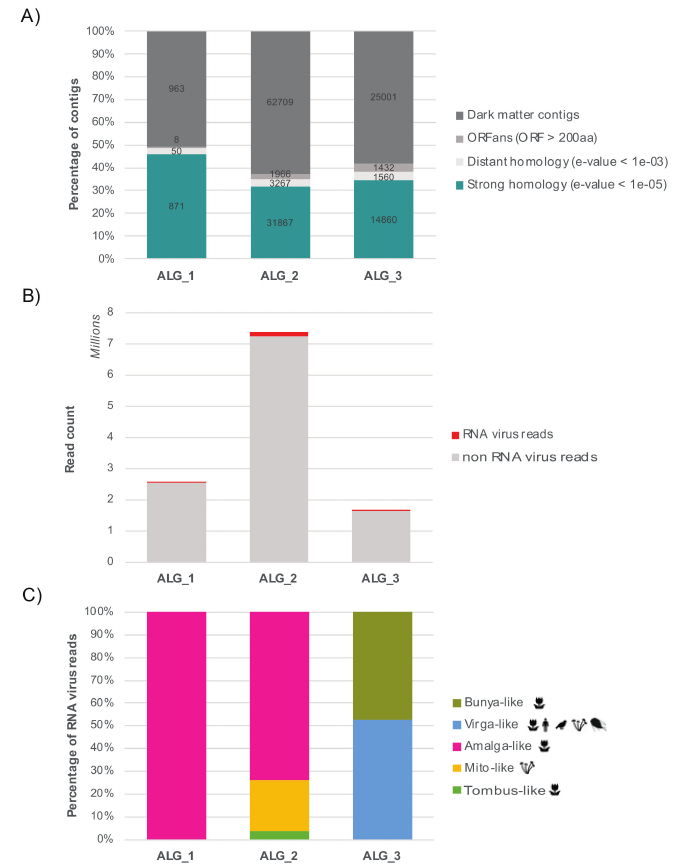
Figure 2. Abundance of unknown and RNA virus-like contigs detected in the algal libraries. ( A ) Percentage of nonassigned contigs. For clarity, numbers are normalized as the percentage of total contigs (actual contig numbers are indicated in bold). Blue: number of contigs showing strong sequence similarity to the nr database (e-value < 10 − 05 ); light grey: contigs showing weak sequence similarity to the nr database (e-values 10 − 05 to 10 − 03 ); middle-dark grey: contigs with no sequence similarity detected by BLASTx / BLASTp but predicted to encode one or more ORFs longer than 200 amino acids (600 nt); dark grey: genomic ‘dark matter’ - contigs without any signal detected or any long ORFs encoded. ( B ) Total number of RNA virus reads per total number of non-rRNA reads in each library. ( C ) Distribution of RNA virus diversity in the three libraries and percentage of RNA virus reads associated with each viral super-clade. The host range is represented for each viral